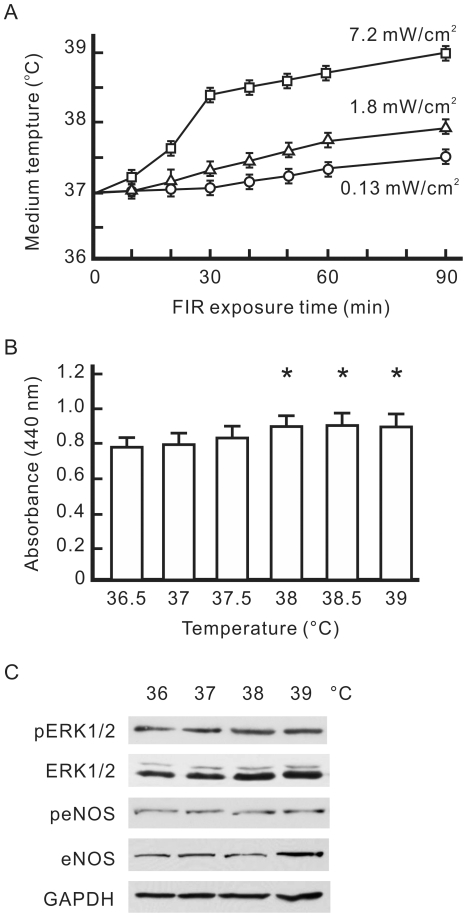
Influence of a thermal effect on VEGF-induced proliferation in HUVECs.(A) FIR exposure-increased the temperature of the culture medium. The temperature of 3 ml of culture medium in 6-cm culture dishes was detected after FIR exposure at 0.13, 1.8, or 7.2 mW/cm2 for the indicated periods. (B) The influence of thermal pretreatment on VEGF-induced cell proliferation. HUVECs were pretreated with VEGF (10 ng/ml), cultured at the indicated temperature for 30 min, and then cultured at 37°C overnight. Data are shown as the mean±S.D. from six experiments. * p<0.05 vs. the group at 37°C. (C) Western blotting of phospho-ERK1/2, ERK1/2, phospho-endothelial nitric oxide synthase (eNOS), and eNOS. HUVECs were pretreated with VEGF, cultured at the indicated temperature for 30 min, and then cultured at 37°C for 8 h. GAPDH was detected as a loading control.